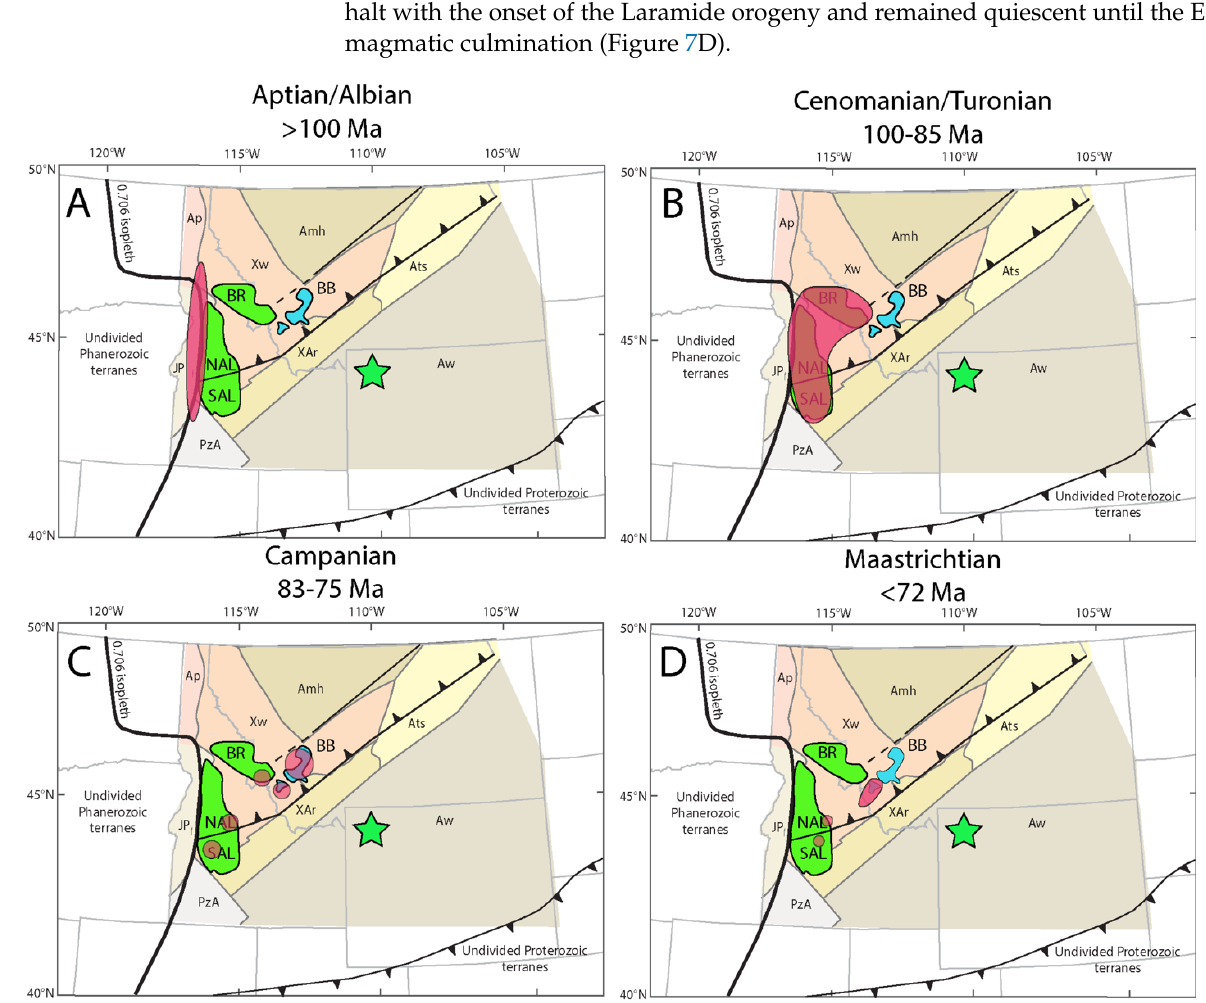
Figure 7. Changing locations of volcanic source areas (shown by red ellipses) through the Cretaceous. See text for discussion of each lettered panel. Green star is the approximate location of the Bighorn Basin, WY. Abbreviations: SAL = Southern Atlanta Lobe, NAL = Northern Atlanta Lobe, BR = Bitterroot Lobe, BB = Boulder Batholith, JP = Jurassic to Permian Ocean-arc rocks, PzA = Paleozoic extended continental crust, Xw = Wallace terrane, XAr = Paleoproterozoic continental-margin/foredeep deposits and Archean gneisses, Ats = tectonically shortened Wyoming terrane, Aw = Archean Wyoming terrane, Amh = Archean Medicine Hat terrane, Ap = Archean Pend Oreille terrane. Simplified basement map modified from [59,60]. Simplified base map modified from [41].